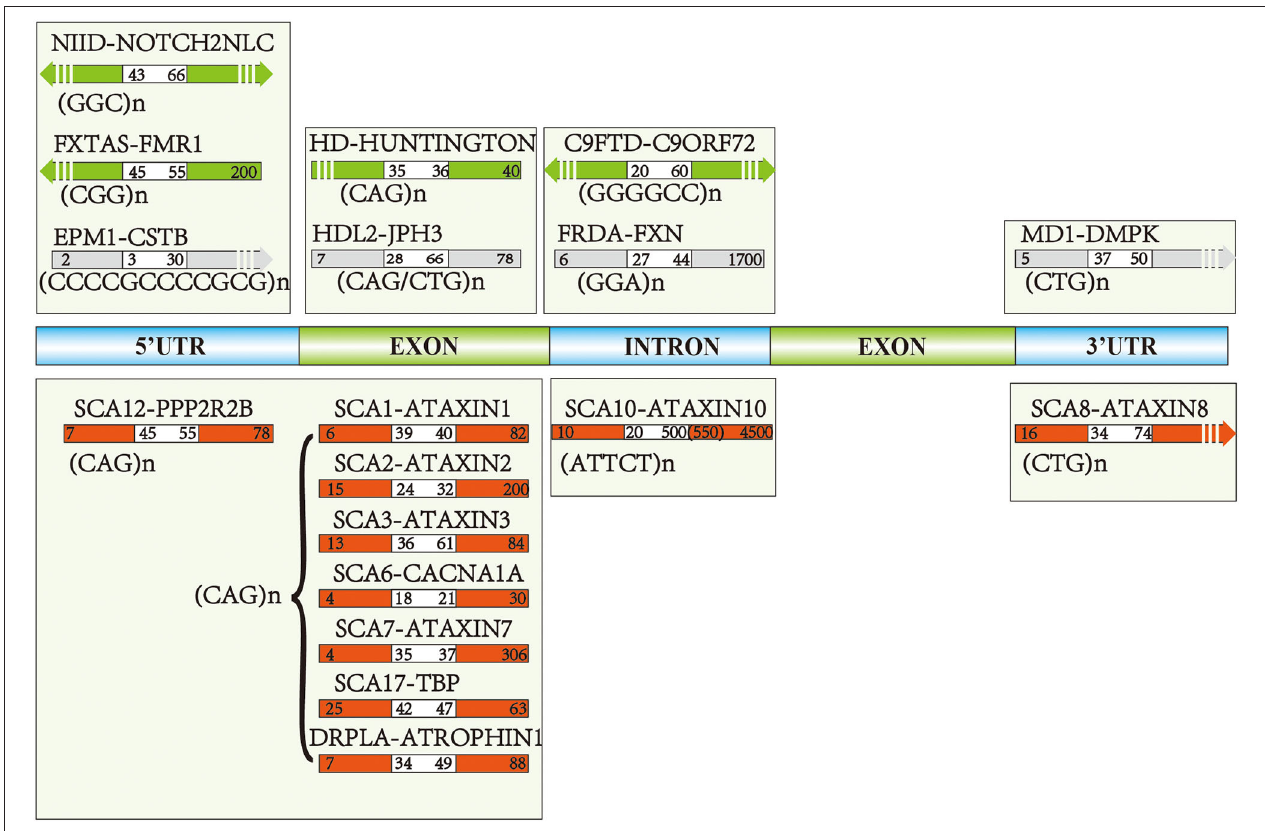
FIGURE 1 | The pathogenic genes and repeat numbers of each disease: green and red arrows reflected pathogenic repeats of the most common repeat expansion diseases (REDs), the gray arrows indicate the diseases with relatively fewer studies focusing on the cognitive aspects. White areas of each arrow represent the intermediate repeats, and the right repeat numbers are pathogenic toward each disease, while left intervals indicate normal repeat